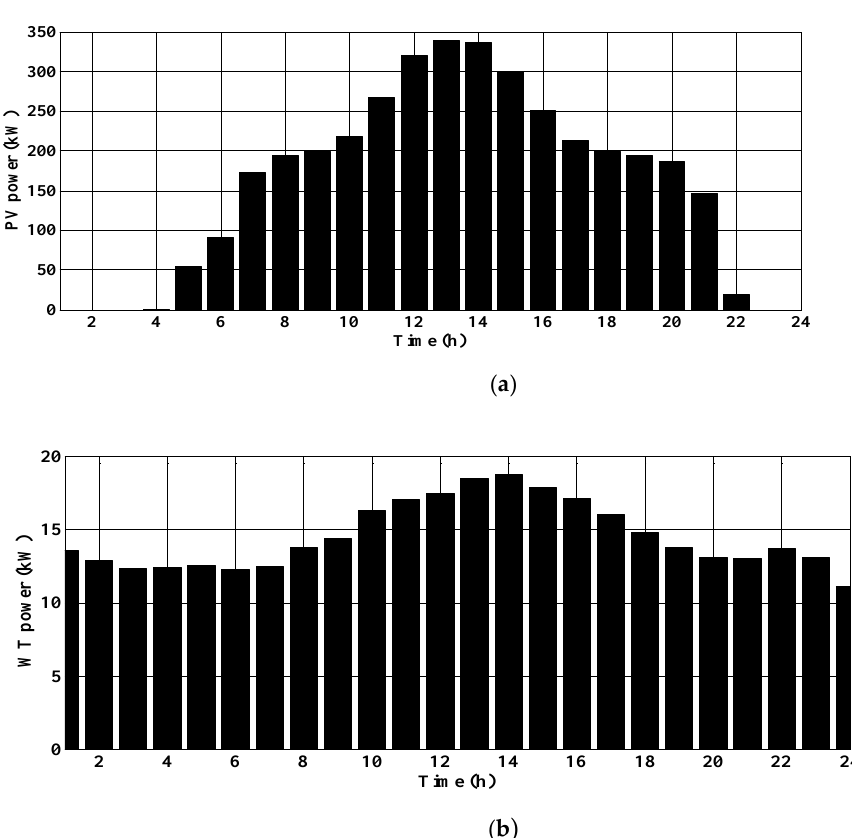
Figure 18. The hourly output power under uncertainty condition of RERs (a) PV unit, (b) WT.